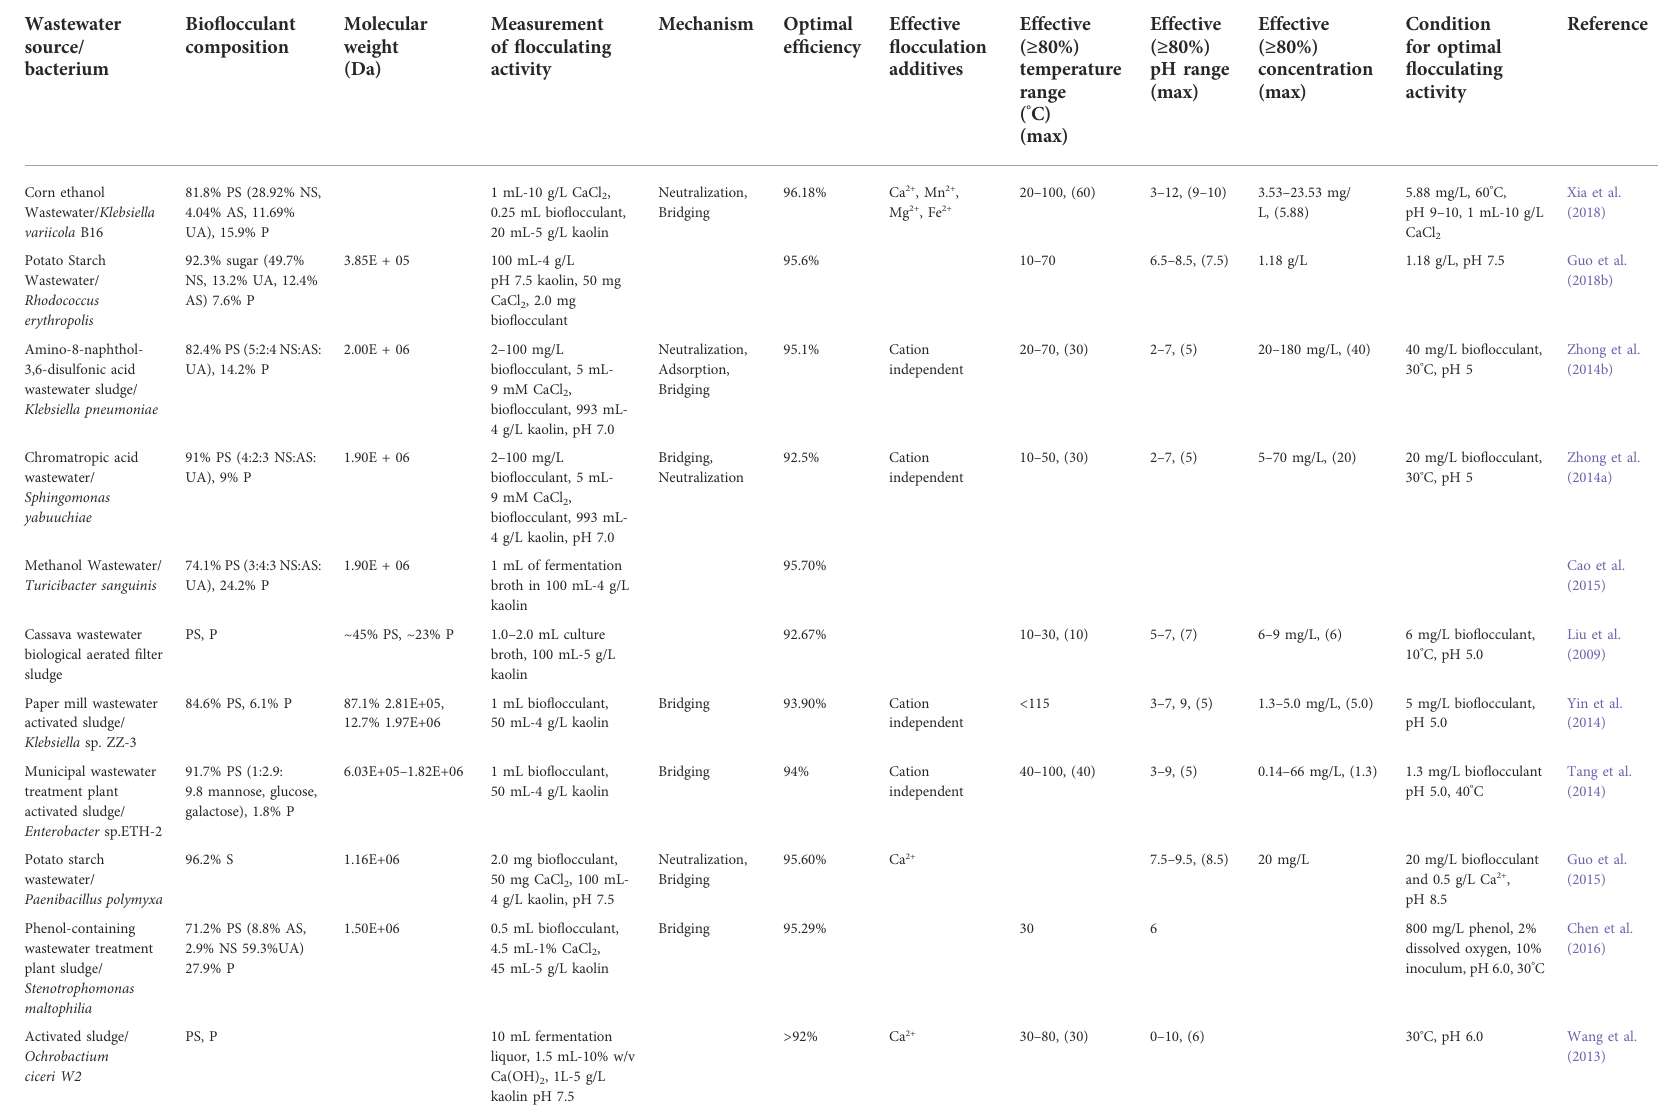
TABLE 3 Bacterium from wastewater and their fl occulation performance. Wastewater source/